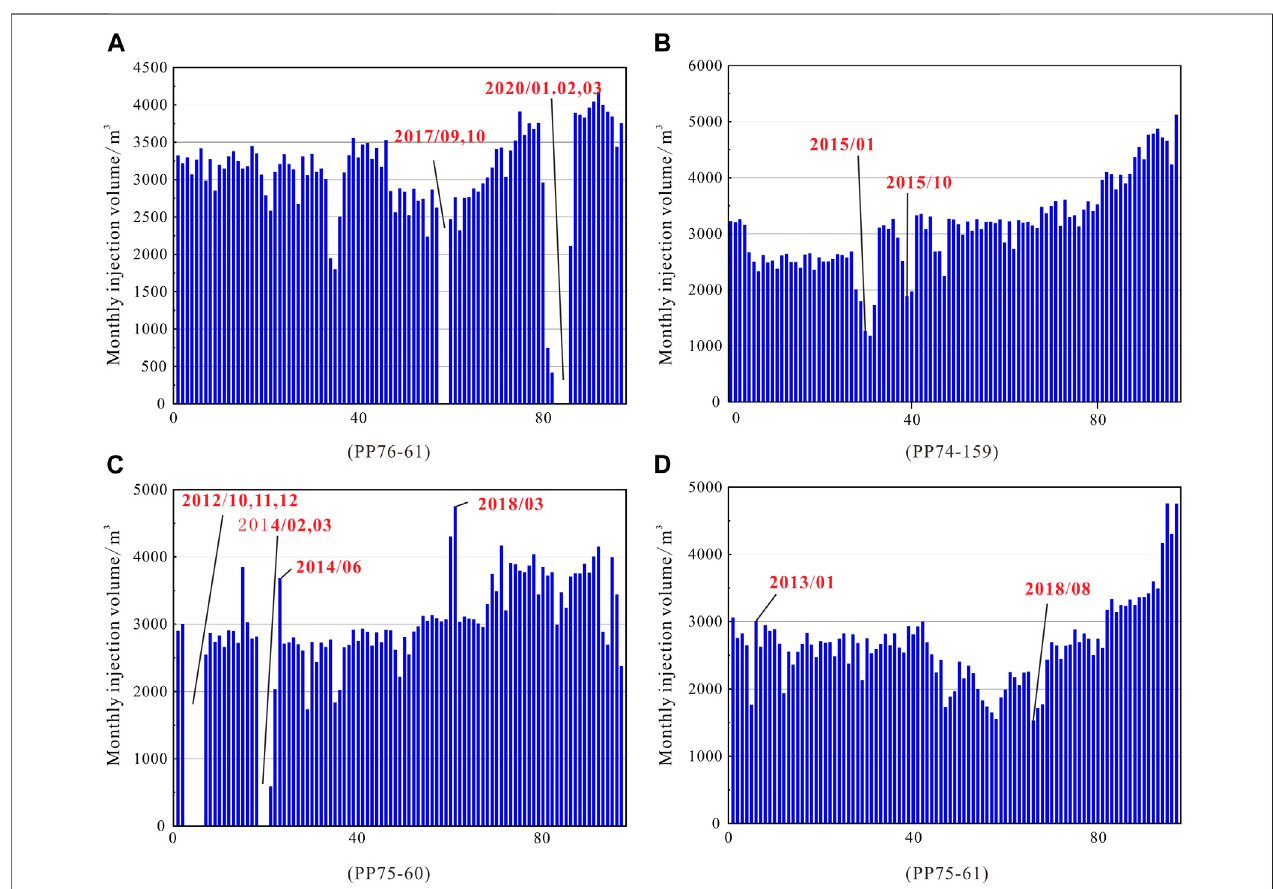
FIGURE 3 | Histogram of monthly injection volume of four water injection wells.